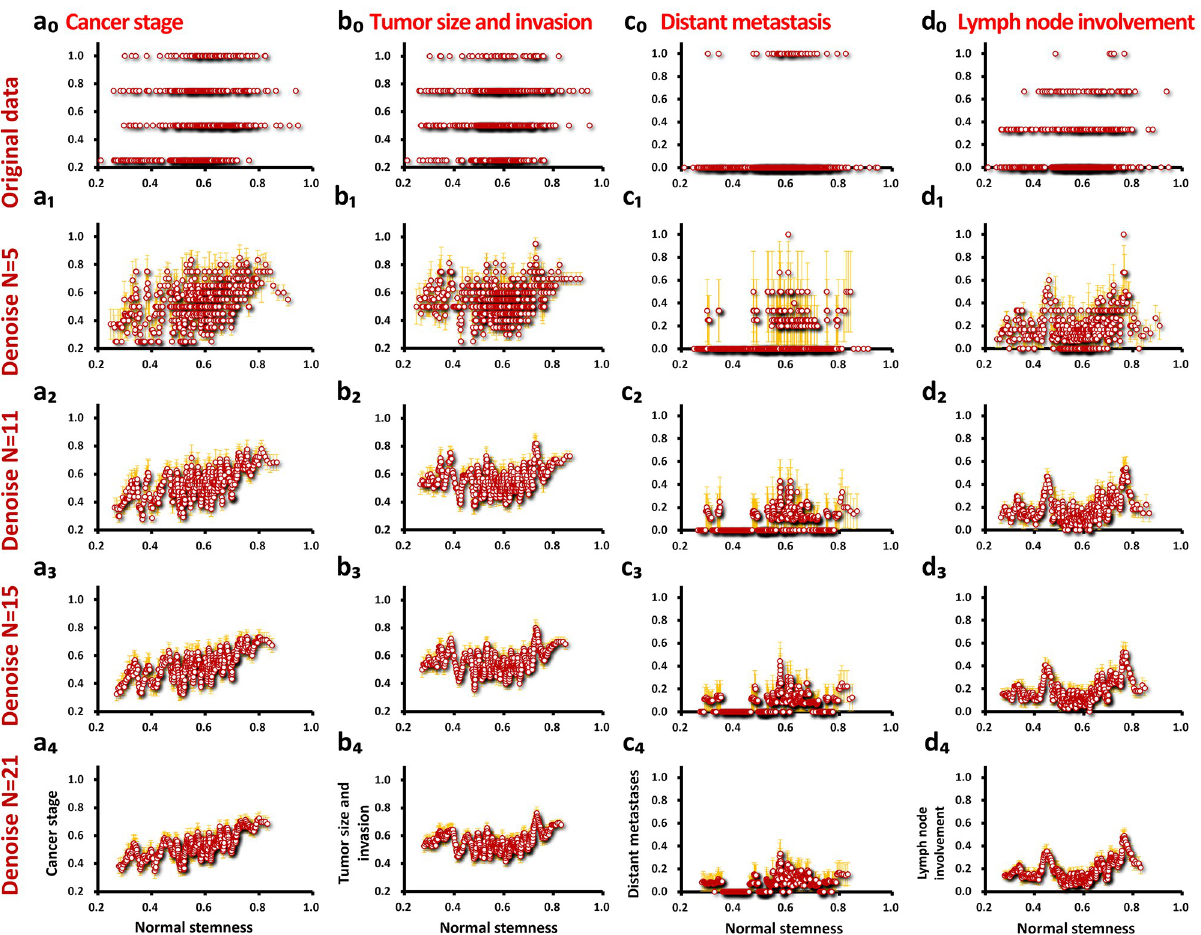
Fig 2. The noise reduction of the four clinical data on the abscissa of the normal tissue stem cell index. We use Table 2 to quantify the four clinical data (a 0 , b 0 , c 0 and d 0 ). Each column is the same clinical data type (a 0 –a 4 : cancer stage; b 0 –b 4 : tumor size and invasion; c 0 –c 4 : distant metastasis; d 0 –d 4 : lymph node involvement). When using higher and higher noise reduction levels (moving window N in Fig 1), the noise becomes lower and lower ( N = 5: a 1 –d 1 ; N = 11: a 2 –d 2 ; N = 15: a 3 –d 3 ; N = 21: a 4 –d 4 ). All abscissas are normal stemness. Orange error bars represent the SEM for each data point.